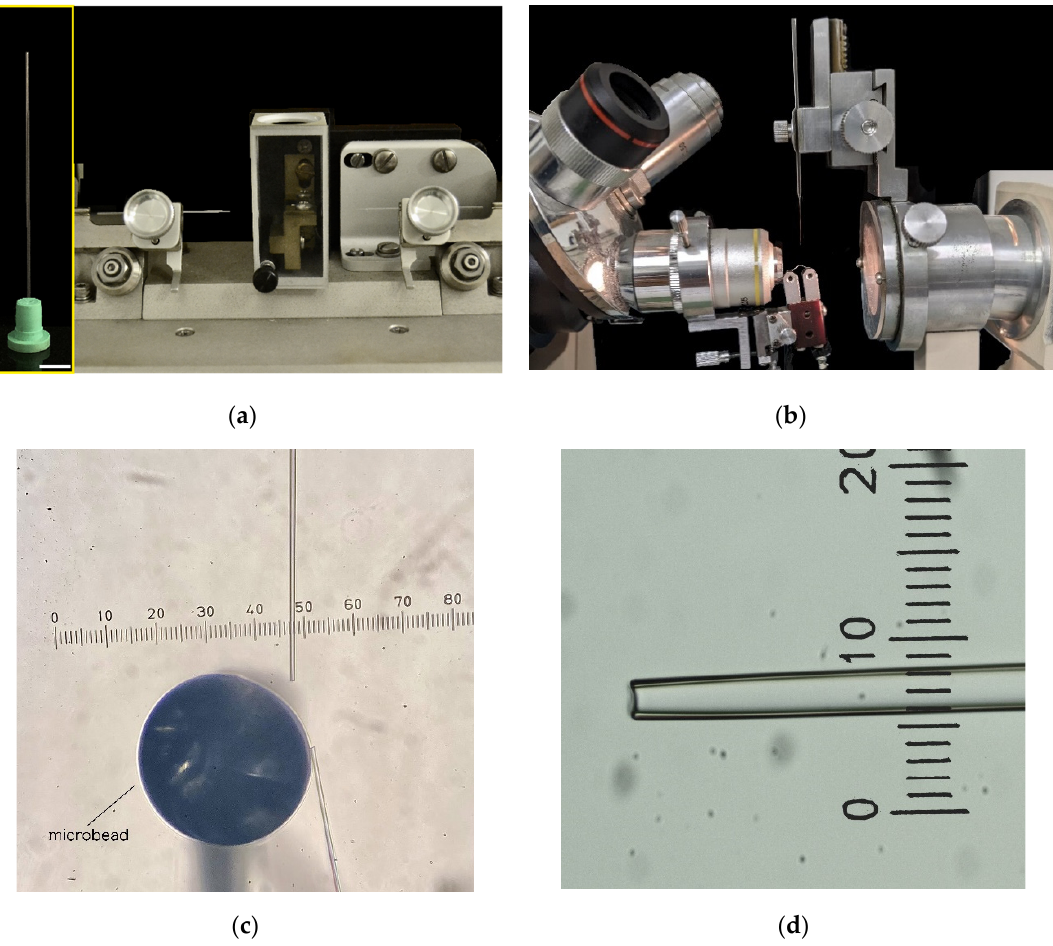
Figure 1. Preparation of the capillary before the picking procedure: ( a ) Borosilicate capillary before the cut and Flaming/Brown micropipette puller holding the cut capillary; ( b ) Cutting and bending of the capillary through a microforge; ( c ) Cut capillary of 10 µm inner diameter; ( d ) Cut capillary of 20 µm inner diameter. Scale bars are also reported.